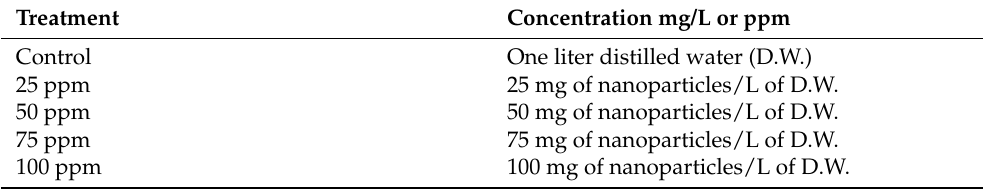
Table 2. Priming treatments layout.